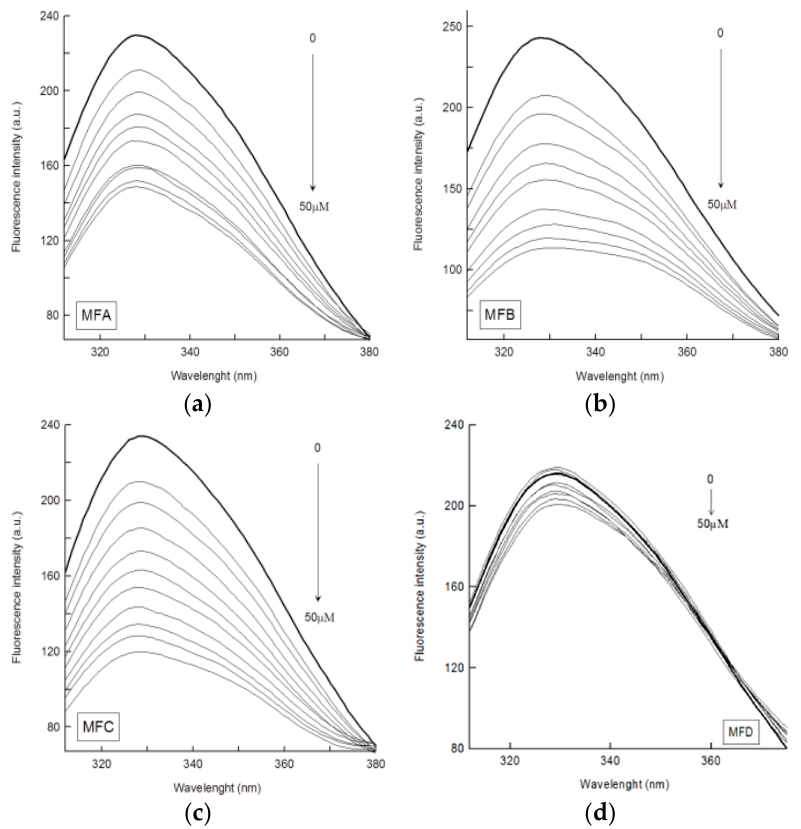
Figure 6. Fluorescence emission spectra of the ( a ) MFA-HTF system, ( b ) MFB-HTF system, ( c ) MFC-HTF system, and ( d ) MFD-HTF system. The concentration of HTF was 4 µ M and that of the compounds was increased from 5 to 50 µ M with a step of 5 µ M ( λ ex = 295 nm, T = 23 ◦ C). The arrow direction shows an increase in compound concentration.